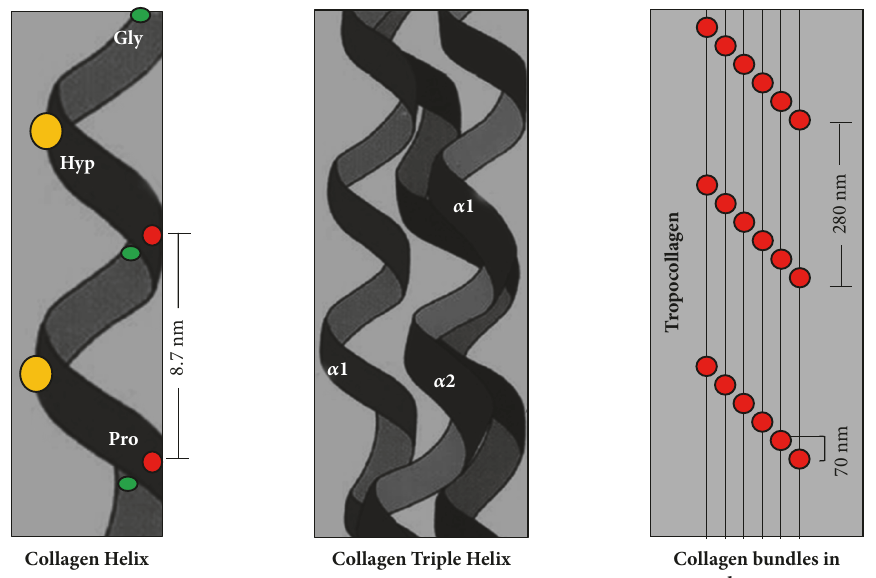
Figure 1: S tructure o f collagen . Each collagen helix is called the 𝛼 chain, which is a levorotatory strand with about 3 residues per turn of glycine (Gly), proline (Pro), and hydroxyproline (Hyp) sequences. The quaternary structure of the collagen fibril is formed from the supercoiling of three 𝛼 chains to form a triple dextrorotatory